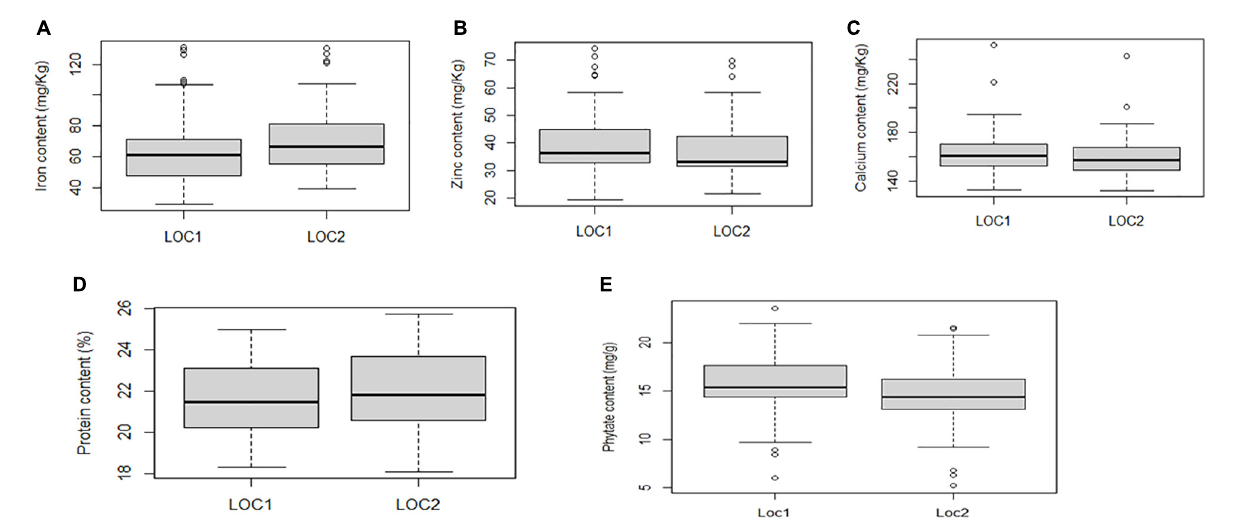
FIGURE 3 | Boxplot view illustrating the distribution of Fe, Zn, Ca, protein, and phytate components across the two test locations. The upper and lower error bars represent the non-outlier range of the data set. The box represents the area from the first quartile to the third quartile. A horizontal line goes through the box at the median. The whiskers (vertical line) go from each quartile to the minimum or maximum. (A) Distribution of Fe concentration across two locations. (B) Distribution of Zn concentration across two locations. (C) Distribution of Ca concentration across two locations. (D) Distribution of protein concentration across two locations. (E) Distribution of phytate concentration across two